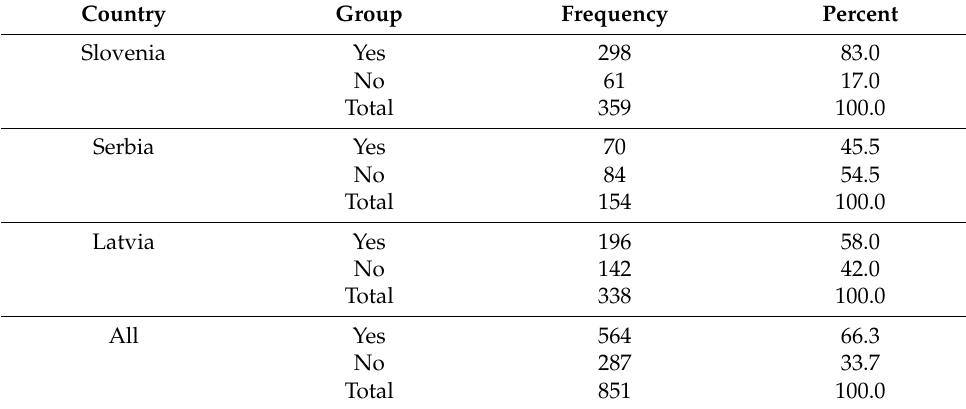
Table A12. Founder or co-founder of the company.